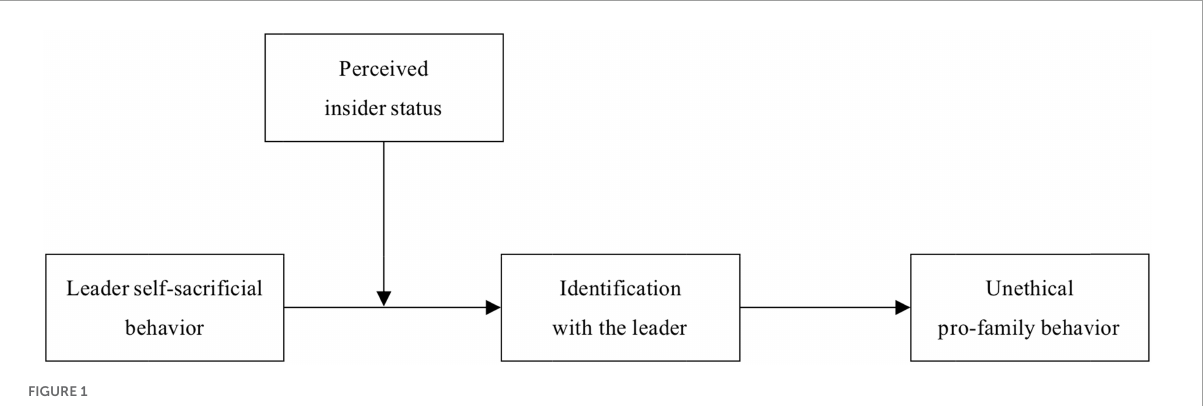
FIGURE1 The research model.